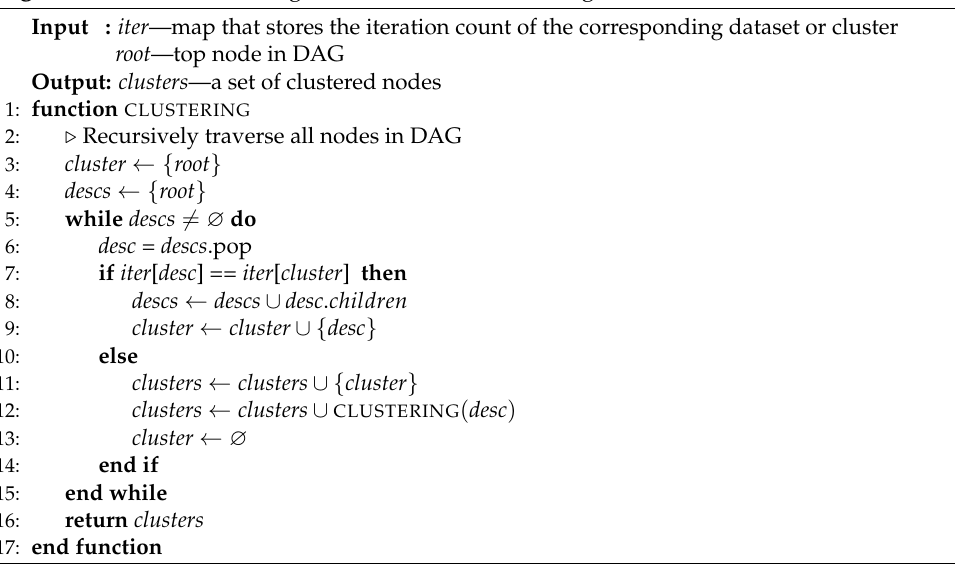
Algorithm 1 A recursive algorithm for DAG clustering